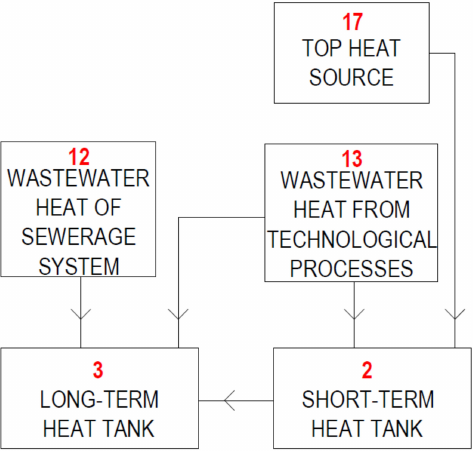
Figure 13. Functional diagram of the combined building-energy system in waste heat recovery mode [17].